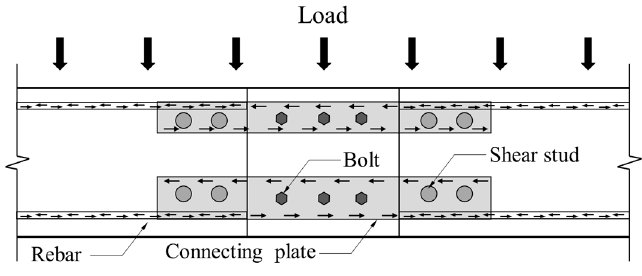
Figure 1. Stress distribution in the proposed connection method.